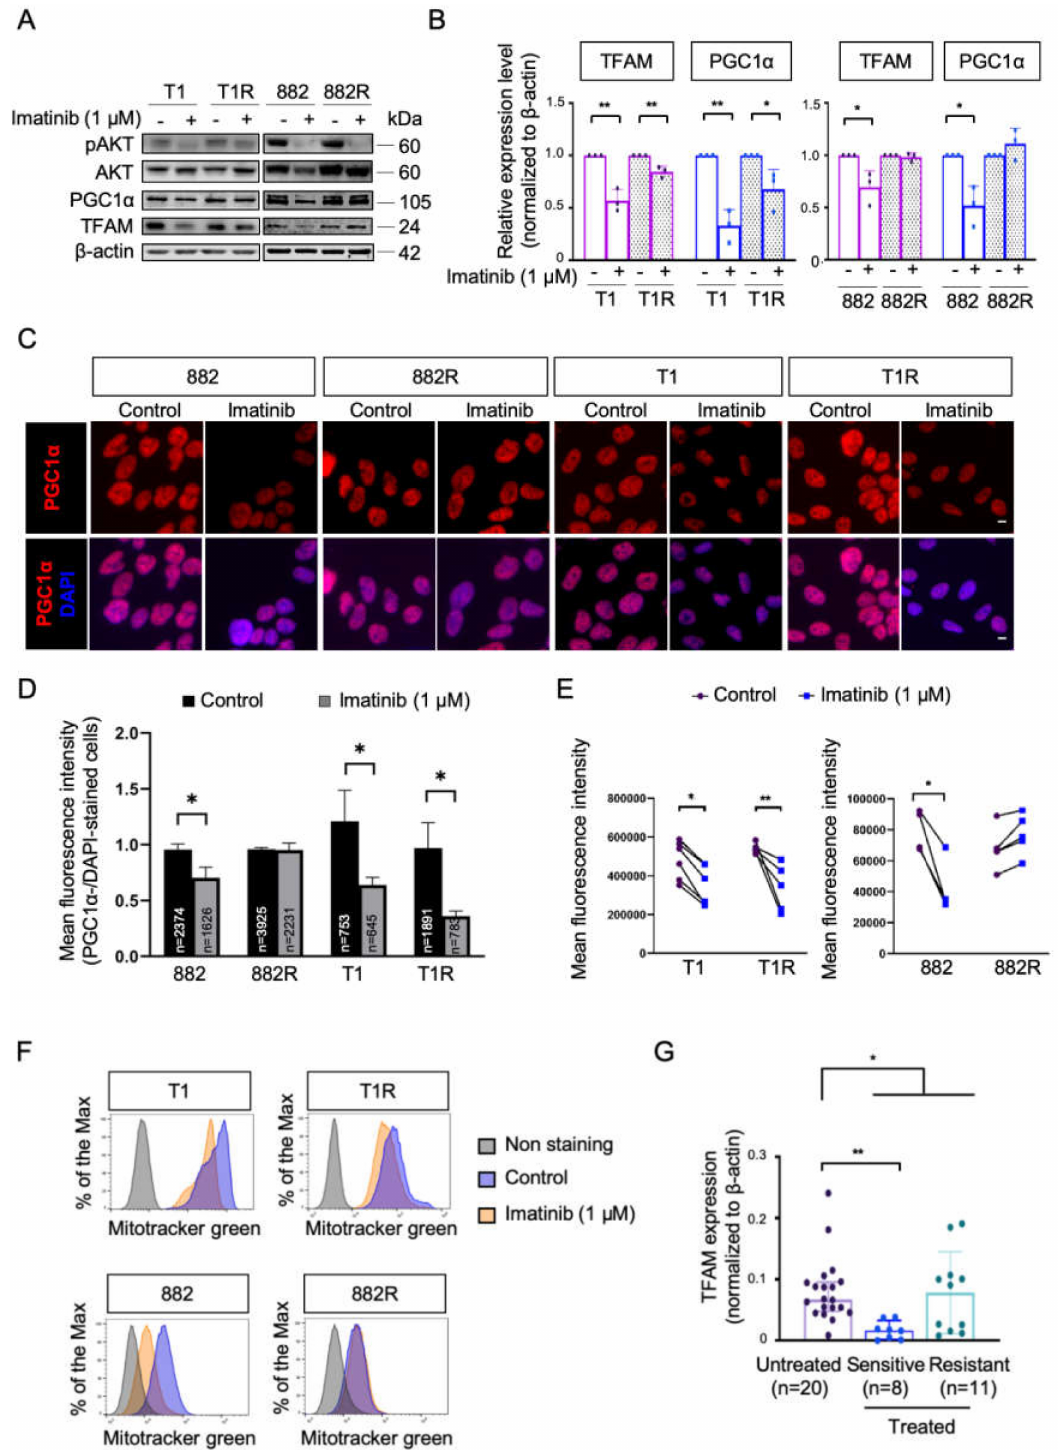
Figure 2. The e ff ect of imatinib on mitochondrial biogenesis in imatinib-sensitive and -resistant GIST cell lines and tumors. ( A ) Representative immunoblots of phosphorylated AKT (pAKT), AKT, peroxisome proliferator-activated receptor coactivator-1 alpha (PGC1 α ), and mitochondrial transcription factor A (TFAM) are shown. The e ffi cacy of imatinib treatment was demonstrated by a marked reduction in pAKT level. ( B ) Quantification of protein expression of PGC1 α and TFAM was normalized to β -actin from 3 independent biological experiments. Histograms represent mean ± SD. * p < 0.05, ** p < 0.01 (Student’s t -test). ( C ) Representative immunofluorescence images show staining for PGC1 α (red) and 4 (cid:48) ,6-diamidino-2-phenylindole (DAPI) (blue) at 20 × objective lens. Scale bar: 10 µ m. ( D )